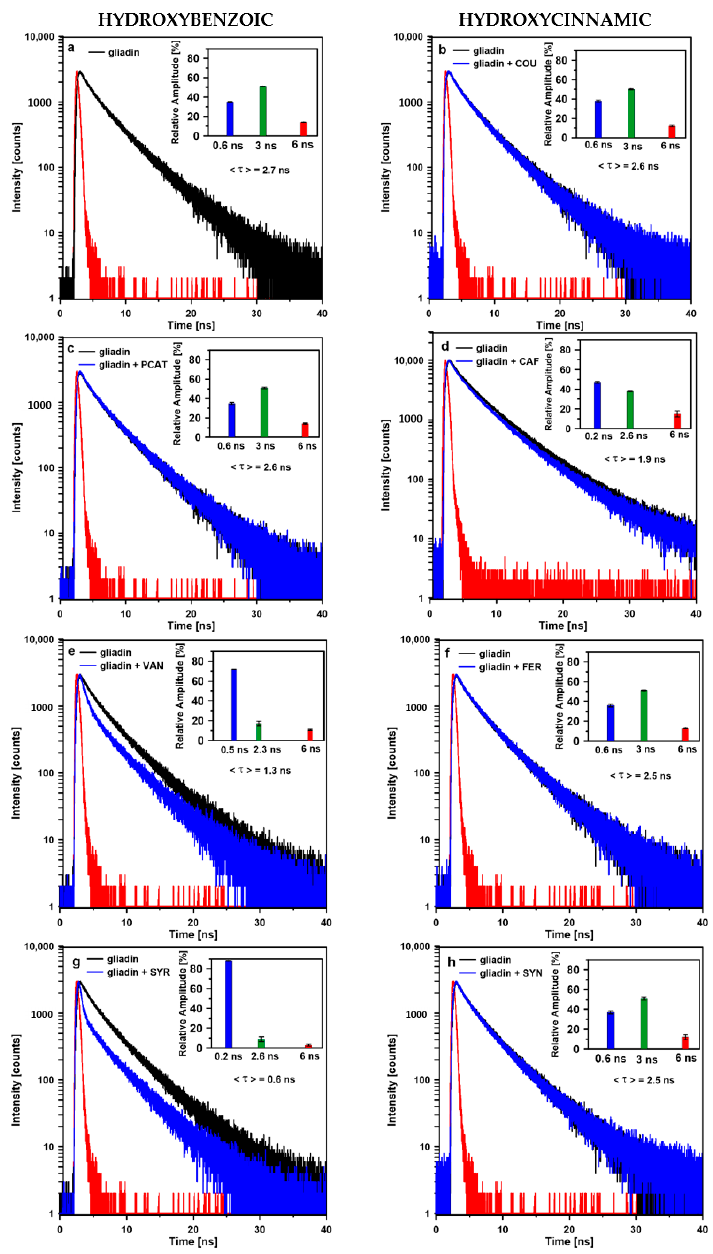
Figure 2. Fluorescence decay kinetics of tryptophan emission in the gliadin ( a ) and gliadin-phenolic acids complexes ( b – h ). Intensity weighted average lifetime < τ > values are presented in the figure. The fluorescence decay kinetics were fitted with three components characterized by appropriate lifetimes for individual samples. The inner panels present relative amplitudes of the fluorescence lifetime components.